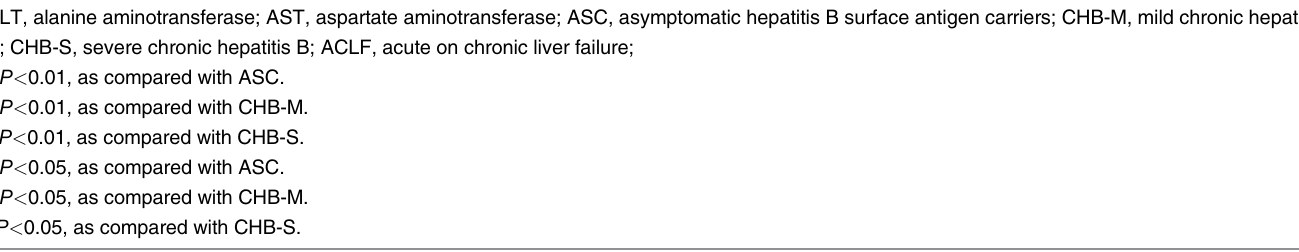
To avoid the potential influence on the results brought by age and sex differences among the 4 groups, we adjusted the age and sex in the flowing statistic analysis process. To clearly describe the associations of mutations in the S region and pre-core /core region of HBV geno- types B and C with ASC, CHB-M, CHB-S and ACLF, we firstly treated ASC as control (Table 4). Mutations at nt.216, nt.285, nt.1896, nt.1913 in genotype B were associated signifi- cantly with an increased risk of CHB-S and ACLF, after the adjustment for age and sex, respec- tively. In subjects with genotype C virus, mutation frequencies at nt.285, nt.1846, nt.1896, nt.1913, and nt.2159 were significantly higher in ACLF and mutation frequencies of nt.1846, nt.1896, nt.1913, nt.2159, and nt.2189 were significantly higher in CHB-S than those in ASC. As compared with patients with CHB-M, mutations at nt.216 and nt.285 were significantly associated with an increased risk of CHB-S in genotype B (Table 4), whereas mutations at nt.1896 and nt.1913 were significantly associated with an increased risk of CHB-S in genotype C. As compared with the patients with CHB-S, mutations at nt.2159 and nt.2189 in genotype B were significantly associated with an increased risk of ACLF, whereas there were no significant- ly differences at these 2 points at ACLF with genotype C (Table 4). As compared with non-ACLF cases, T216C, G285A, A1846T/G, G1896A, C1913A/G, A2159G/C, A2189T/C in genotype B and G285A, A1846T/G, G1896A, C1913A/G and A2159G/ C in genotype C were significantly associated with an increased risk of ACLF(see Table 5).